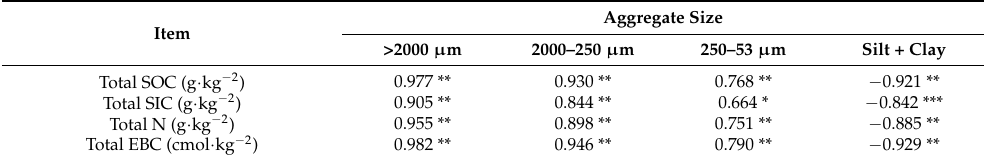
Table 3. Correlation between aggregates and different indexes.